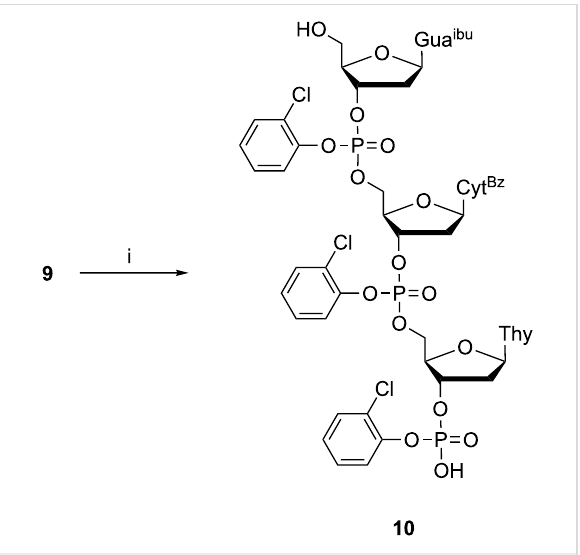
Scheme 4: Cleavage of oligonucleotides from support. Reagents and conditions: (i) tris(2-carboxyethyl)phosphine hydrochloride, Et 3 N,